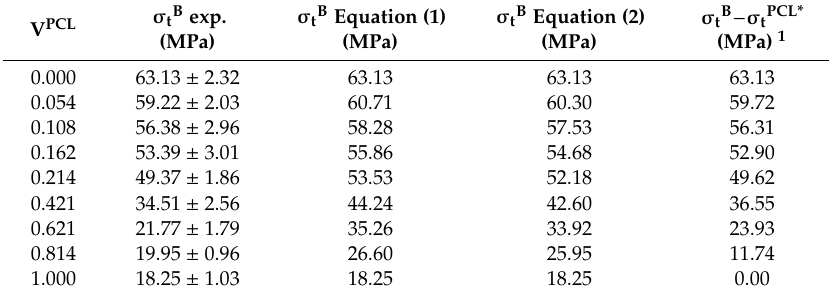
Table 3. Theoretical tensile strength of the blends computed with di ff erent versions of RoM compared to experimental values.